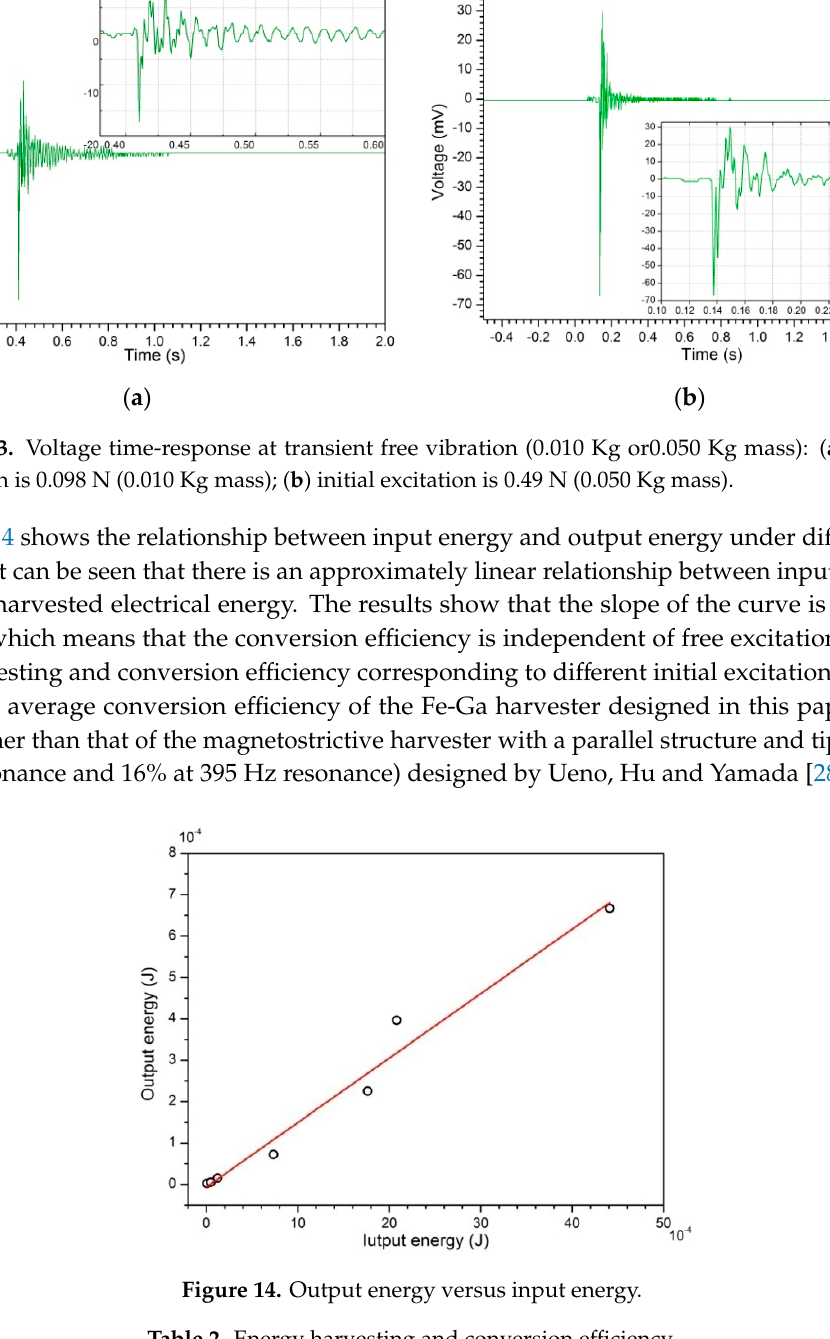
Figure 14. Output energy versus input energy. Table 2. Energy harvesting and conversion e ffi